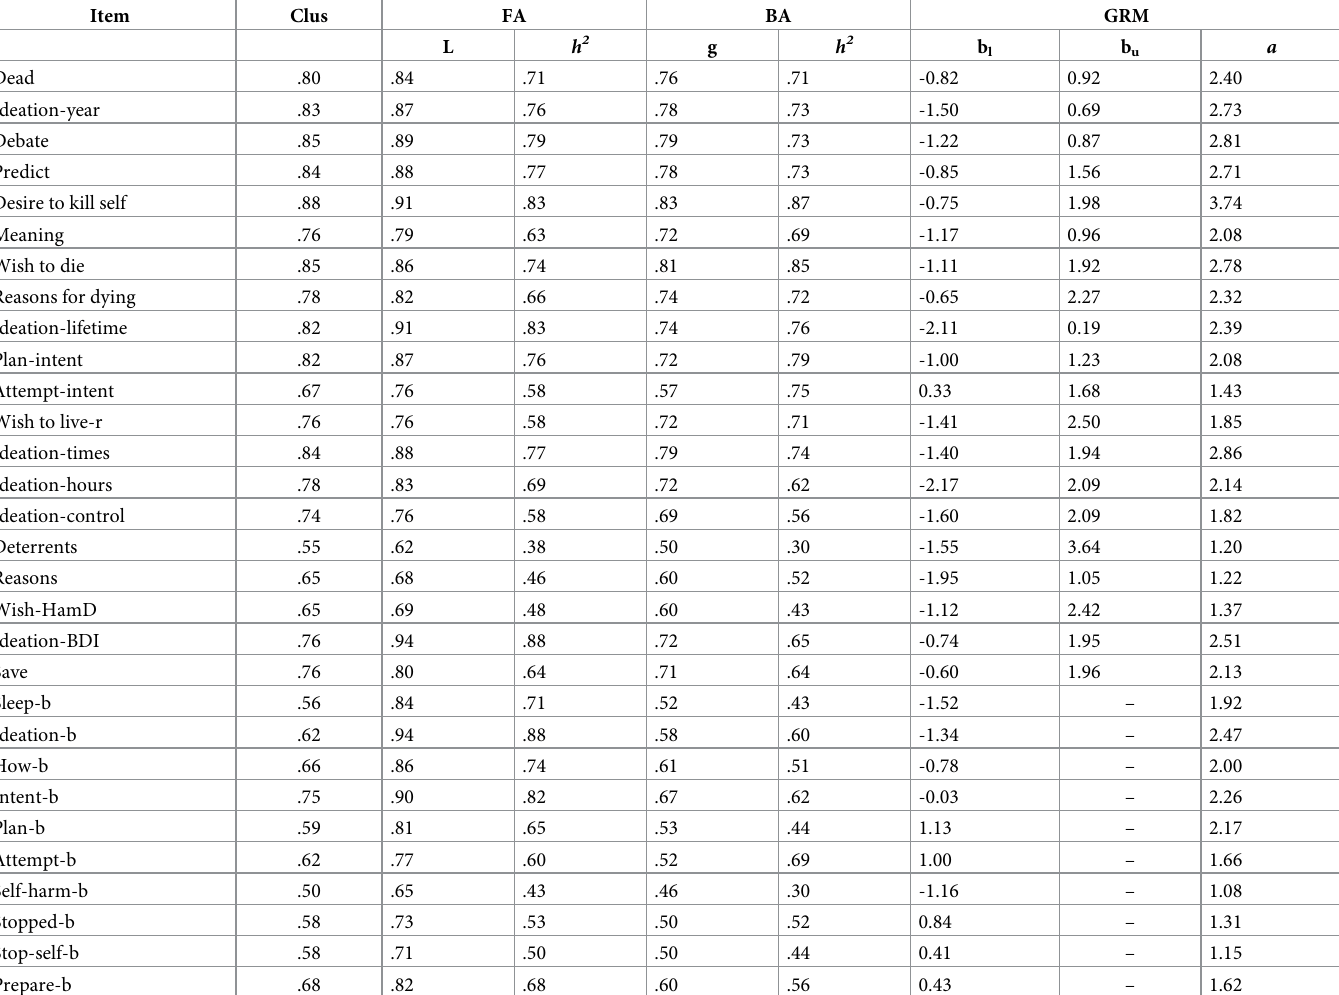
Table 2. Item pool cluster, factor analysis, bifactor analysis and graded response